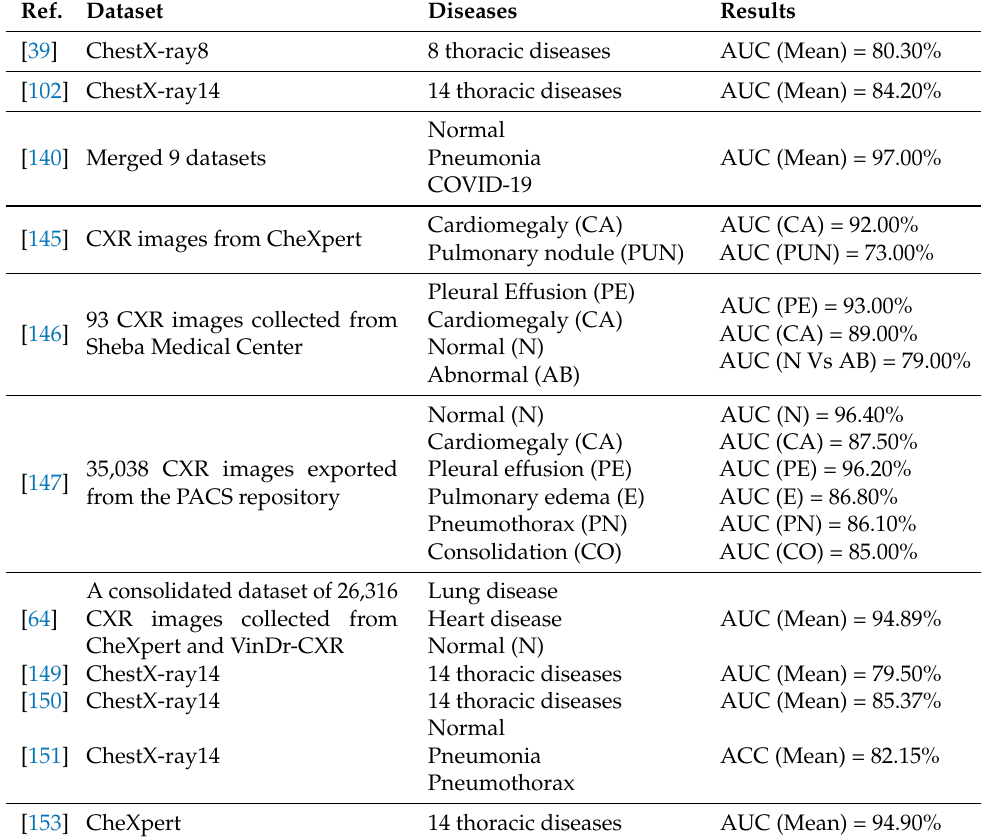
Table 11. Overview of different DL architectures for multiple disease